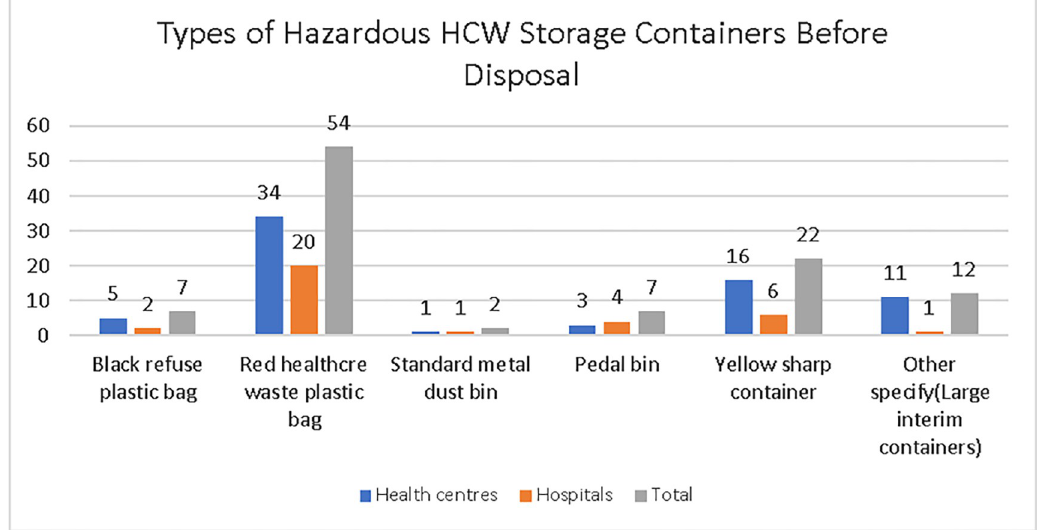
Fig 6. Type of Hazardous HCW storage containers before disposal in the study health facilities, Addis Ababa City Administration, February